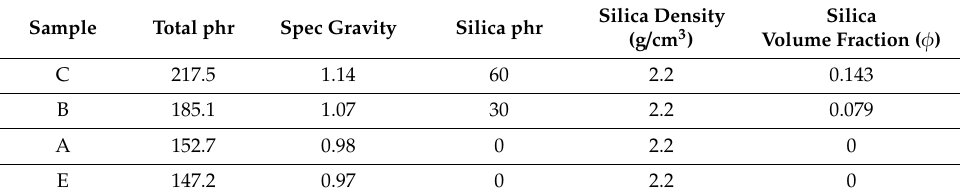
Table 2. Silica content in the di ff erent samples. phr is parts per 100 g of